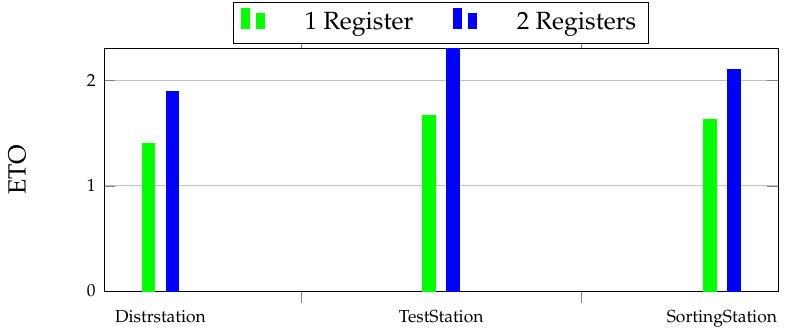
Figure 18. Measured execution time